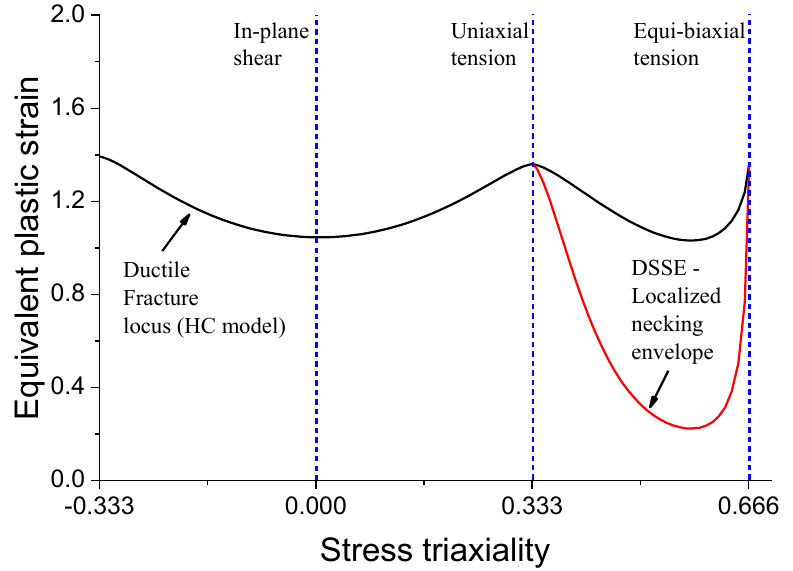
Figure 11. Hosford–Coulomb Fracture locus with localized necking envelope for JIS G3131 SPHC.